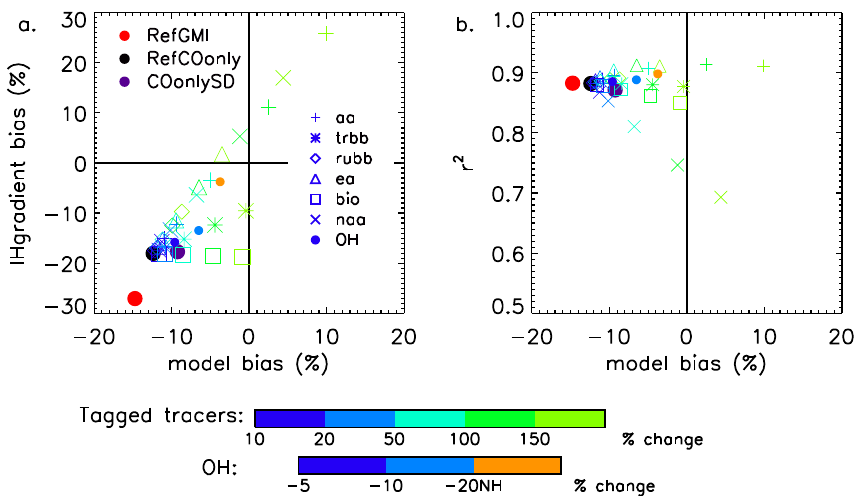
Figure 4. The impact of increasing the tagged-CO tracers for Asian anthropogenic ( + ) , tropical biomass burning (stars), Russian biomass burning (diamonds), European anthropogenic (triangles), biogenic (squares), and North American anthropogenic (x) sources on (a) bias in the inter-hemispheric gradient versus global mean bias and (b) correlation versus global mean bias compared to GMD observations from March to May. Large circles represent the RefGMI (red), RefCOonly (black), and COonlySD (purple) simulations. Small circles show the impact of changing global or NH OH in the RefCOonly simulation.